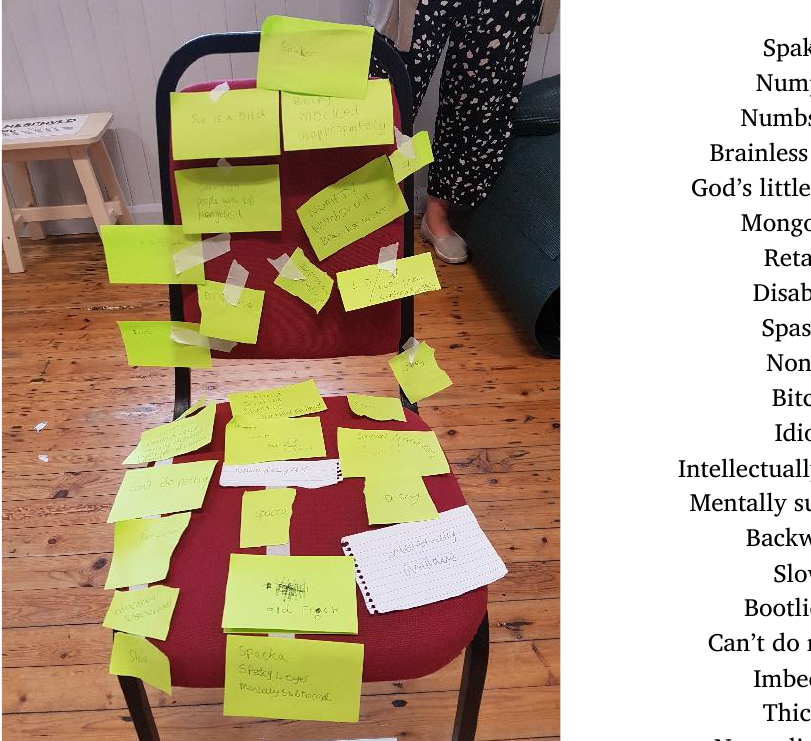
Figure 2. The labels of learning